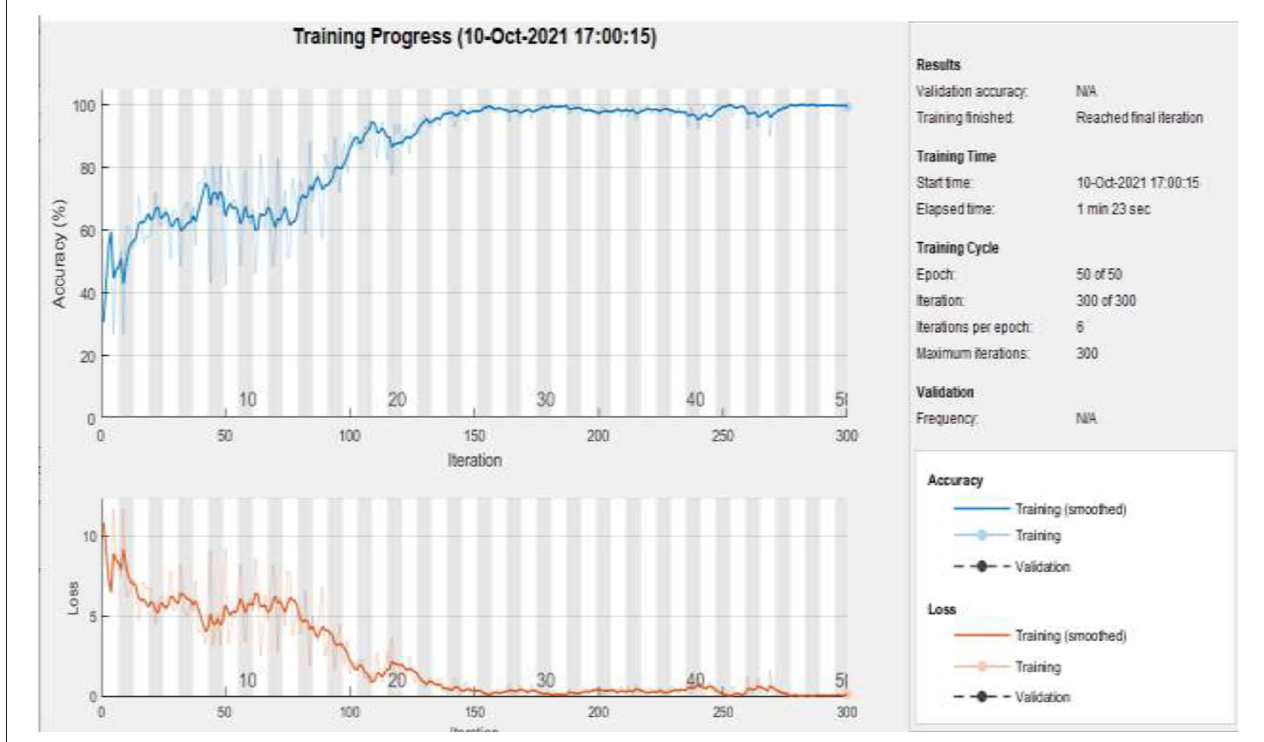
FIGURE 9 | Training of dataset A at 50 epochs.